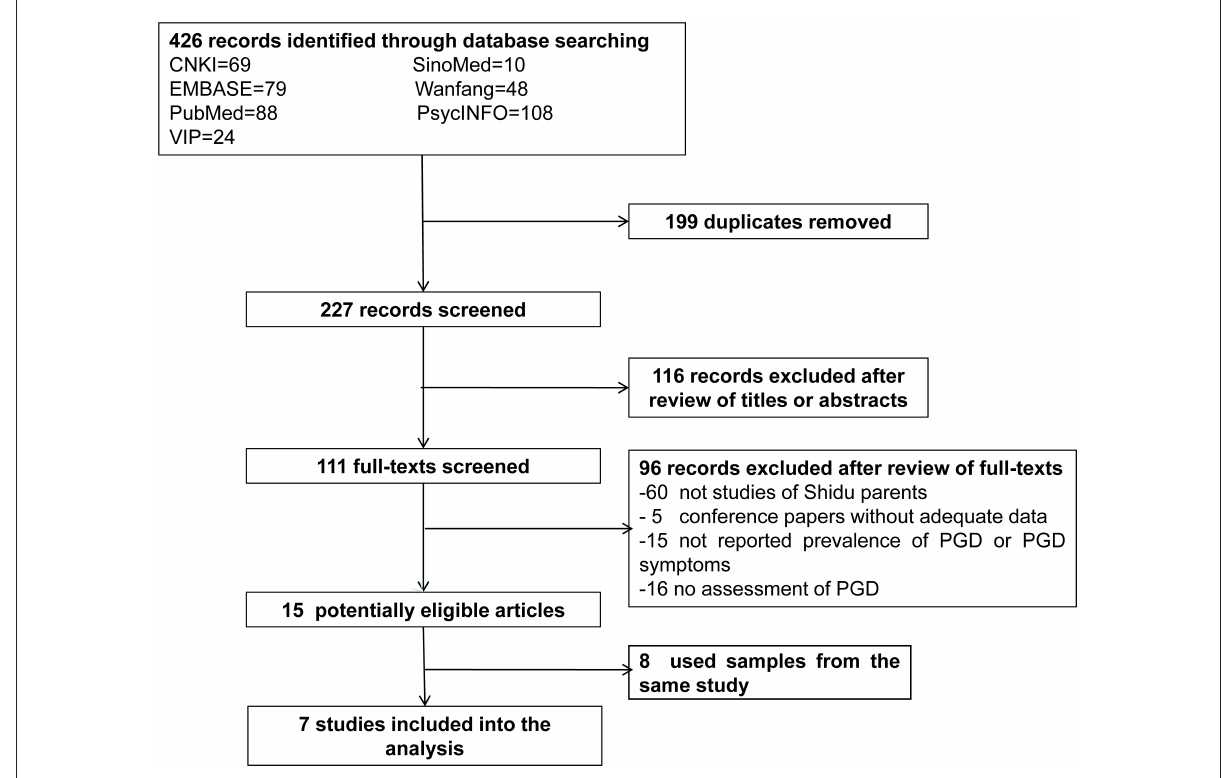
FIGURE1 Flowchart of study